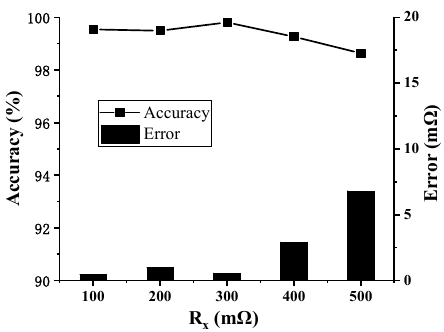
Figure 10. Detection accuracy and error.